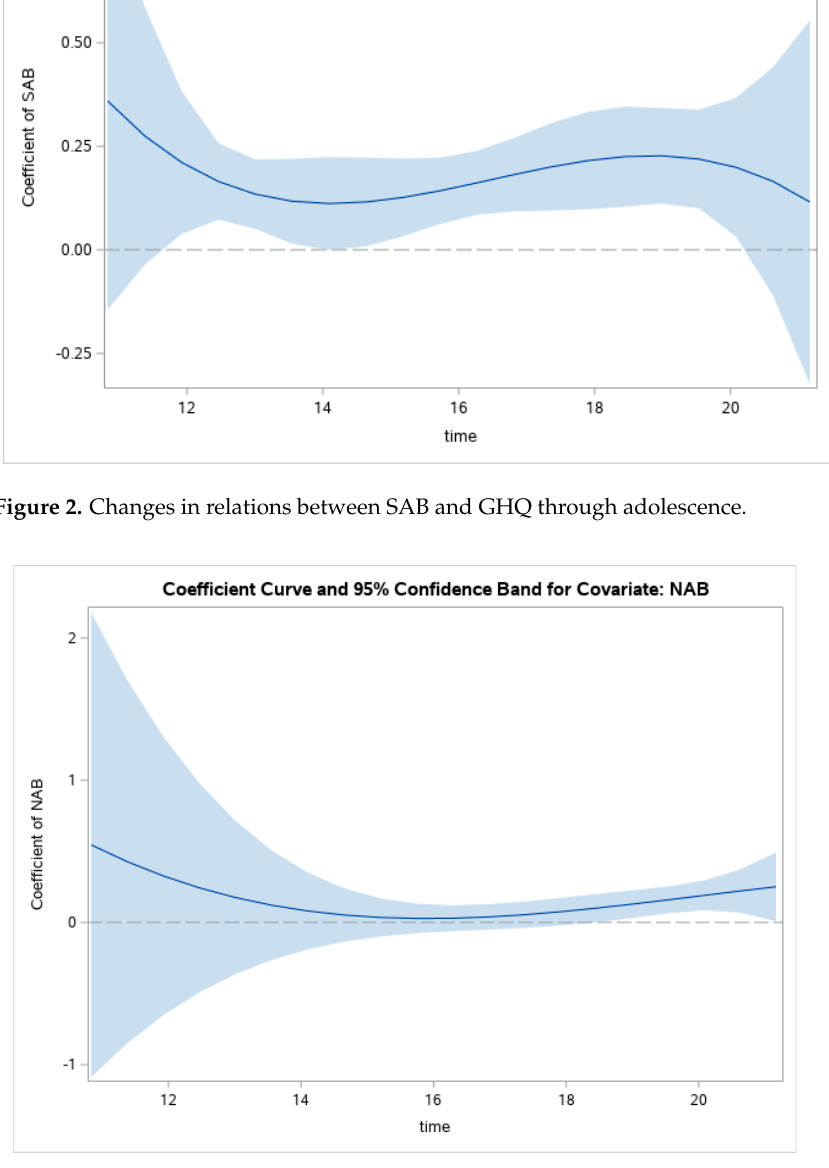
Figure 3. Changes in relations between NAB and GHQ through adolescence.